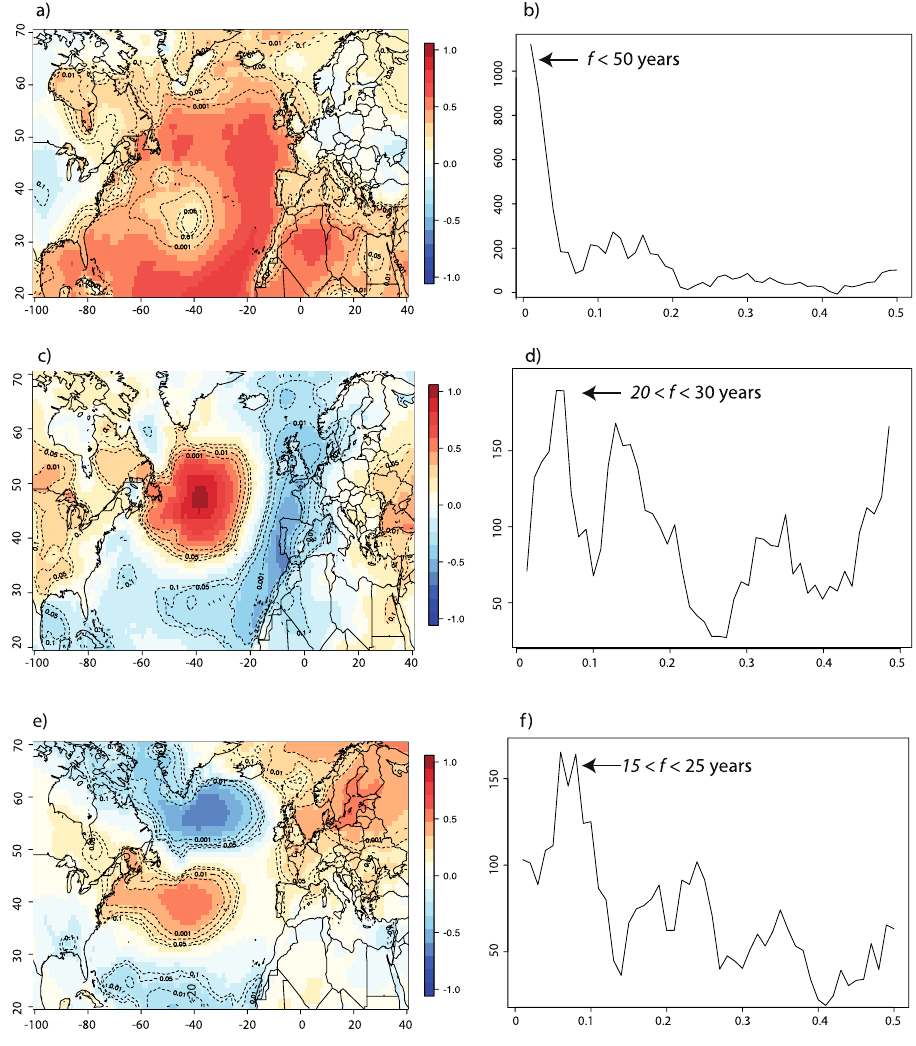
Figure 7. Correlations between the three first PCs of North Atlantic summer SSTs and surface air temperatures: PC1 ( a ), PC2 ( c ) and PC3 ( e ). The associated spectral power for each PC: PC1 ( b) , 31% explained), PC2 ( d) , 11% explained) and PC3 ( f ), 9% explained). Dotted lines represent p values for these correlations, after taking into account serial autocorrelation. Maps generated in R 63